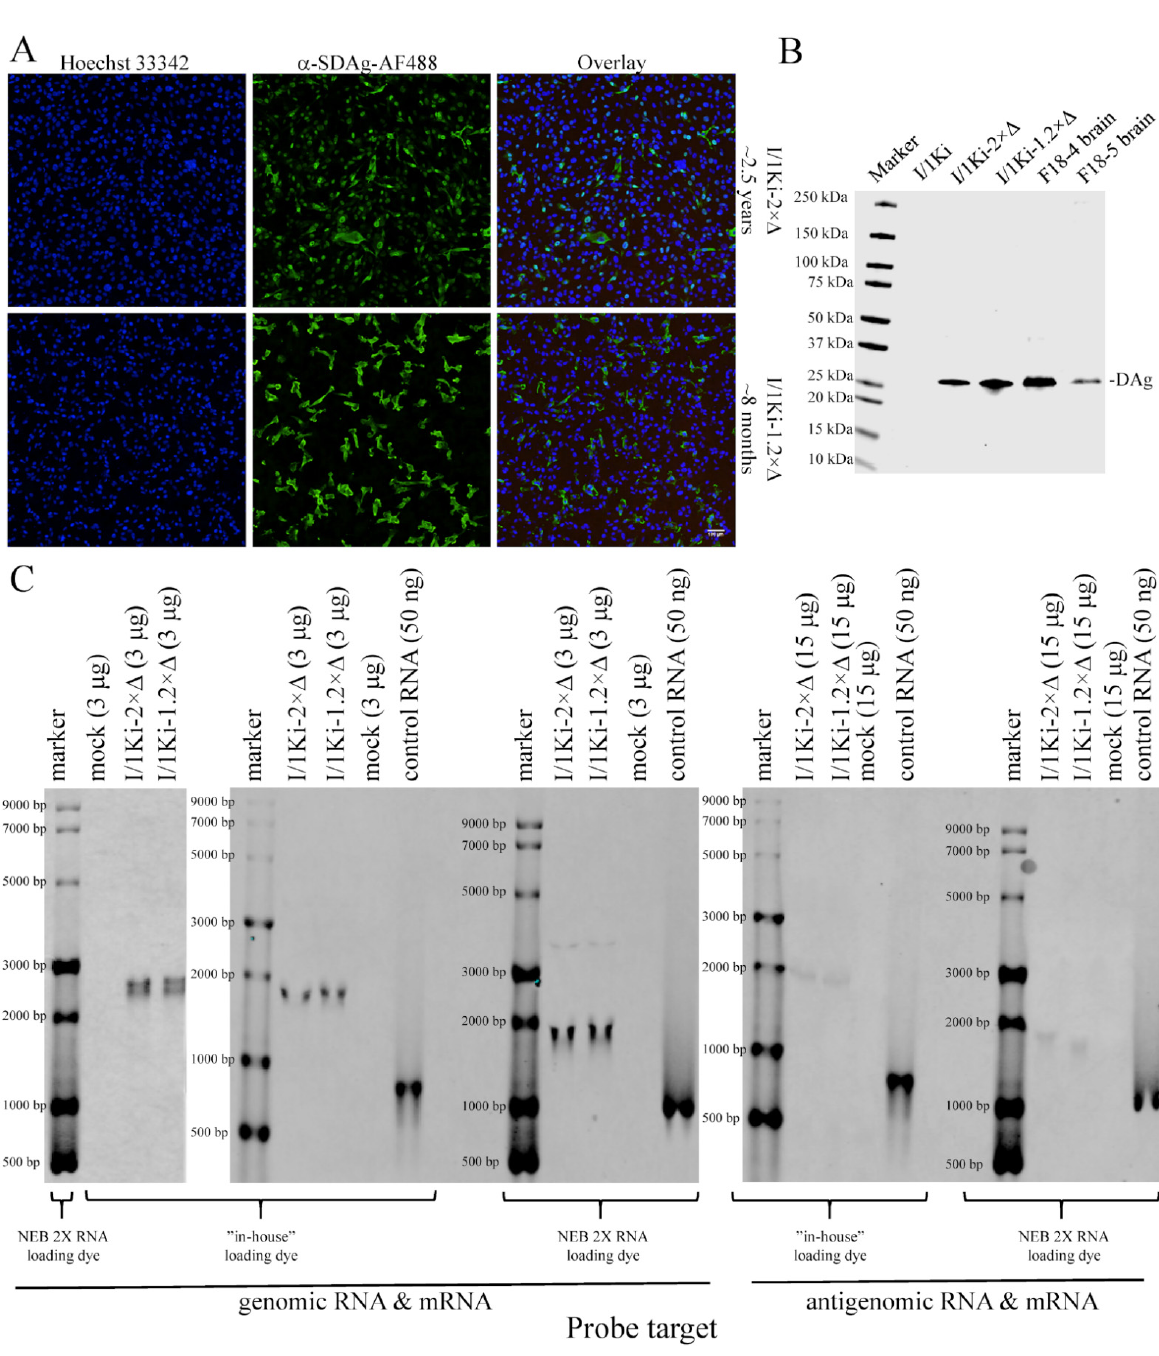
Figure 6. Comparison of persistently SwSCV-1-infected I/1Ki cells generated following transfection with 2× and 1.2× SwSCV-1 FWD constructs by immunofluorescence, and western and northern blot. The 2× SwSCV-1 (I/1Ki-2× Δ ) cell line was analyzed at approximately 2.5 years and the 1.2× SwSCV-1 (I/1Ki-1.2× Δ ) at approximately 8 months after initial transfection, during which the cell lines were passaged at 1–2 week interval. ( A ) Rabbit α -SwSCV-1 DAg antiserum and Alexa Fluor 488-labeled donkey anti-rabbit secondary antibody served for IF staining of the fixed cells, and Hoechst 33342 for staining the nuclei. The top panels show staining of I/1Ki-2× Δ cells, and the bottom panels the staining of I/1Ki-1.2× Δ cells. The left panels show staining of nuclei in blue, the middle panels show